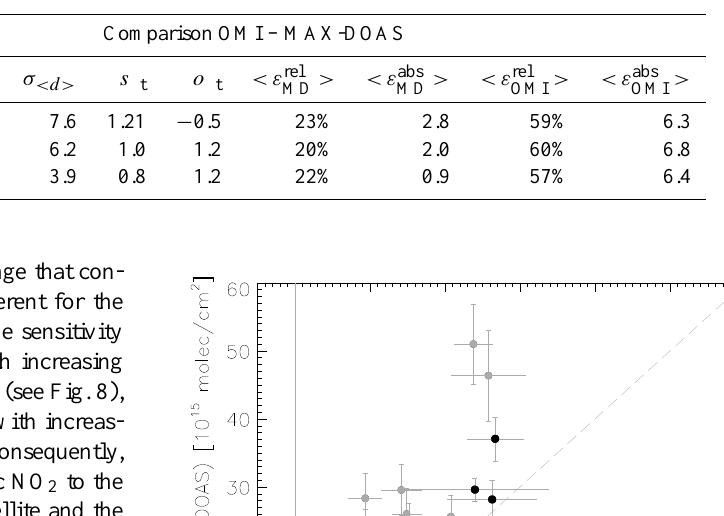
Table 2. Comparison between OMI and MAX-DOAS tropospheric NO 2 . The three rows represent three different sets of selection criteria that are applied to the ground-based retrieved tropospheric NO 2 columns. Each set consists of an upper limit of the relative measurement uncertainty ( ε rel in percent) and an upper limit of the absolute measurement uncertainty ( ε abs in 10 15 molec/cm 2 ). A point is selected if MD MD it satisfies one or both of the limits. The other columns are: number of collocations that satisfies these criteria ( n ), correlation ( R ), mean difference ( < d > in 10 15 molec/cm 2 ), standard deviation of differences ( σ <d> ) in 10 15 molec/cm 2 , slope ( s fit ) of linear fit that minimizes the sum of the squared orthogonal distances, y -axis offset of this linear fit ( o fit in 10 15 molec/cm 2 ), mean relative and absolute measurement > in percent and <ε abs > in 10 15 molec/cm 2 ), and the same quantities for the satellite uncertainty of the ground based observations ( <ε rel MD MD > and <ε abs > ). observation: ( <ε rel OMI OMI